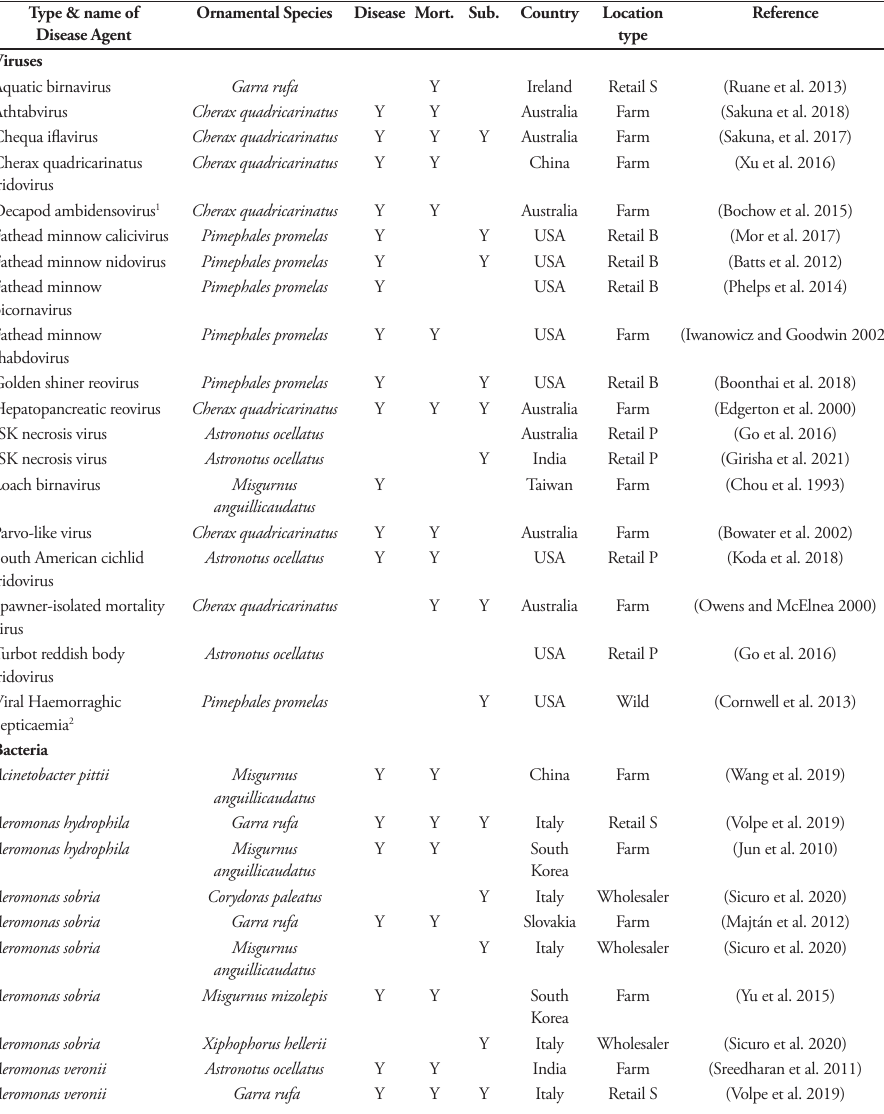
Table 3. List of potential pathogens and parasites reported as natural infections of ornamental fish and invertebrate species traded into the UK , whereby literature evidence was found (Y = Yes) for: Disease = clinical signs or disease in the animal caused by the associated pathogen or parasite; Mort. = mortalities in the animal as a result of the associated pathogen or parasite; Sub. = sub-clinical or asymptomatic infection in the animal. Location types: ‘Aquarium’ includes reports on specimens held in aquaria by hobbyists, public aquaria, vets or laboratories; ‘Retail (Pet shop)’ (Retail P) includes ornamental fish shops, both stand-alone and within ornamental markets; ‘Border’ refers to Import/Border Border Control Inspection Posts; ‘Retail B’ = Retail bait shop; ‘Retail S’ = Retail